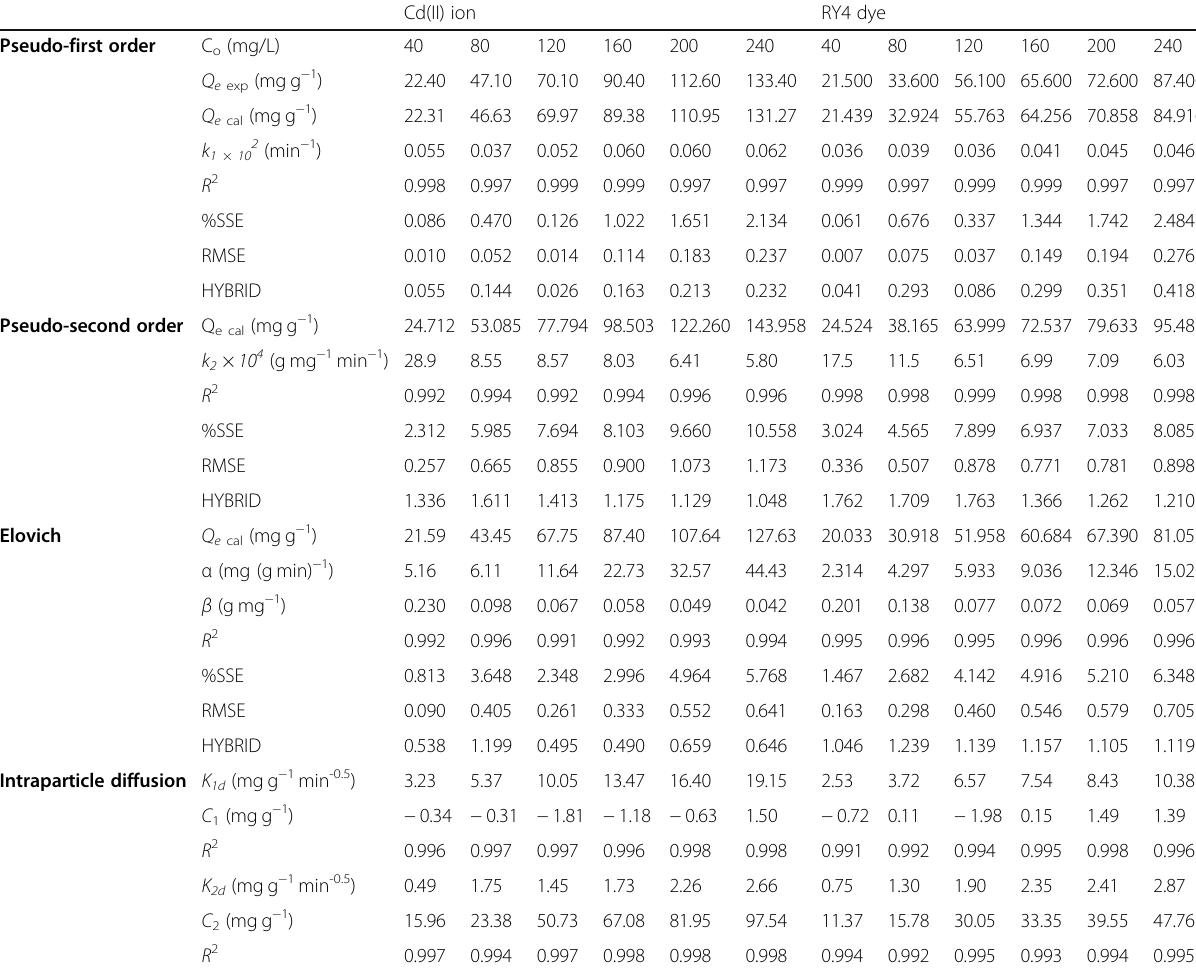
Table 3 Kinetic parameters for the adsorption of Cd(II) ions and RY4 by BMDA Cd(II) ion RY4 dye